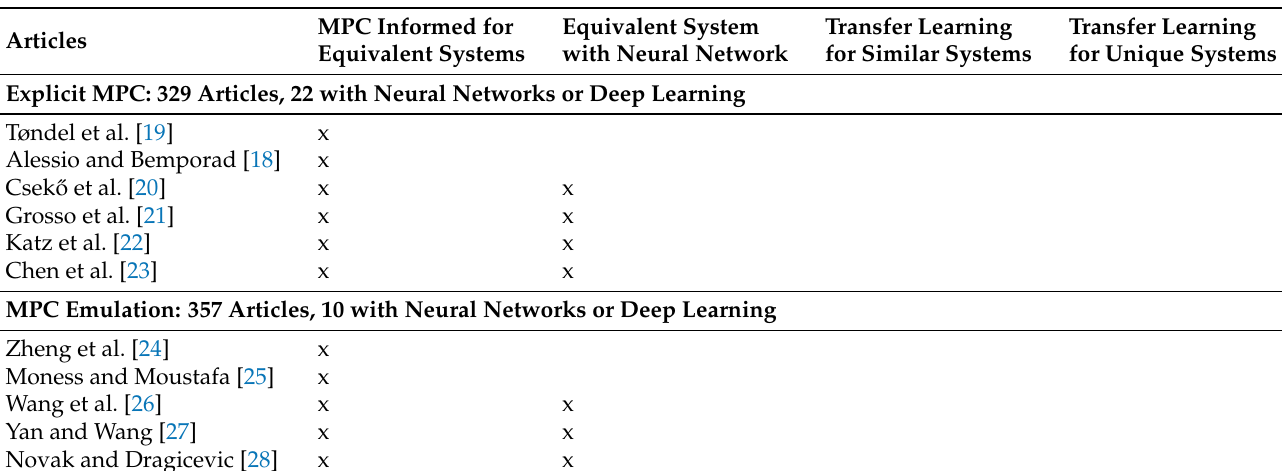
Table 1. A non-comprehensive survey on explicit MPC, MPC emulators and approximate